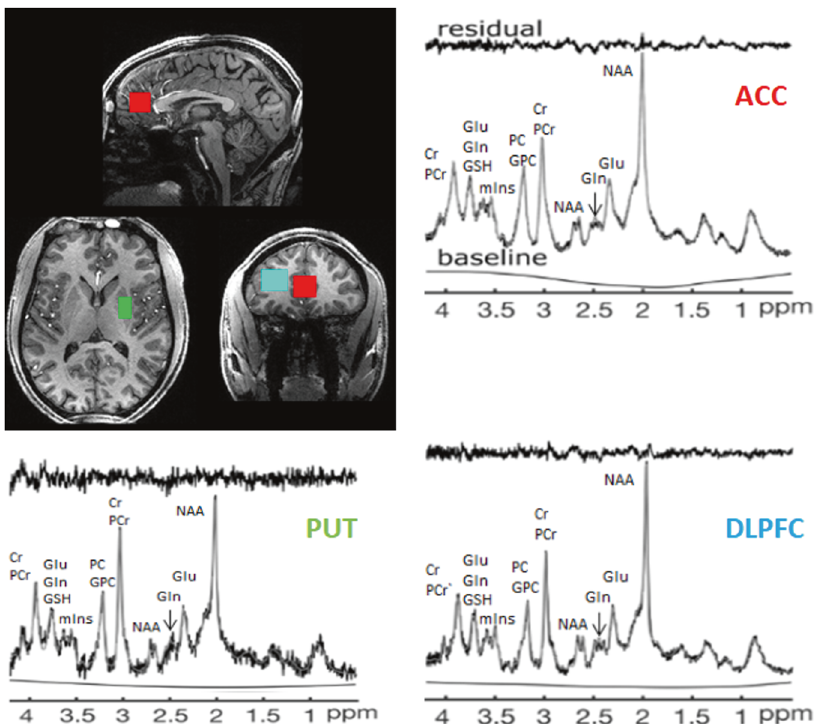
Fig. 1 Voxel placement and representative spectra from the ACC (red), PUT (green) and DLPFC (DLPFC). Glu glutamate, Gln glutamine, GSH glutathione, Cr creatine, PCr phosphocreatine, myoIns myo-inositol, PC phosphocholine, GPC glycerophosphocholine, NAA N-acetylaspartate, Asc